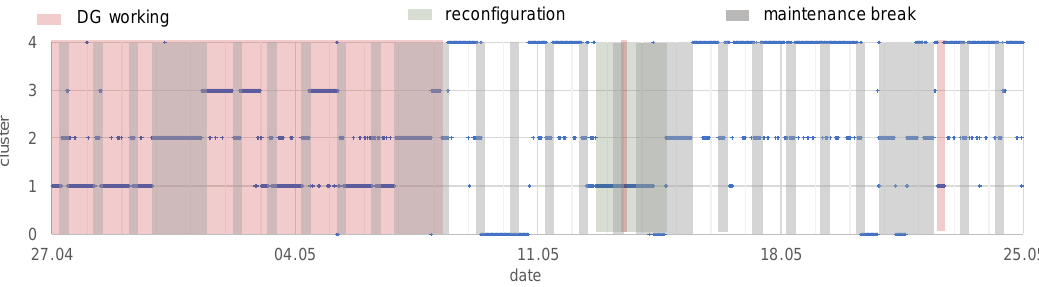
Figure 7. Cluster analysis results for the final number of clusters equal to 4.